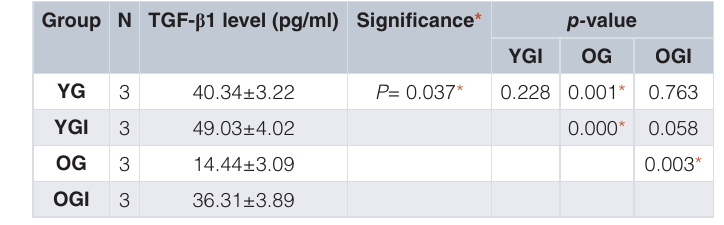
Table 1. Descriptive statistics and results of the Anova and Tukey HSD tests comparing the TGF- β 1 in the 4 groups tested at day 1 after orthodontic appliance installation.